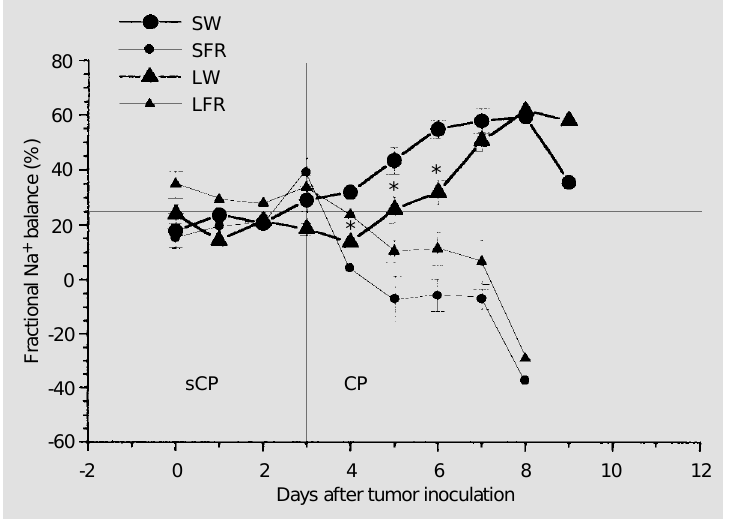
Figure 3 - Time course of sodium retention induced by the tumor in septal-lesioned tumor-bearing rats (LW; N = 15) compared with sham-operated tumor-bearing rats (SW; N = 7) and their respective non-tumor-bearing controls, sham-operated food- restricted (SFR; N = 7) and lesioned food-restricted (LFR; N = 10) rats. The fractional sodium balance was calculated as (input-output) x 100/input, where input is the food intake (g/day) x diet sodium content (mEq/g), and output is the urine volume (ml/day) x urine sodium concentration (mEq/ml). During the clinical period (CP), the tumor- induced Na + retention was temporarily reduced in LW rats compared with SW rats (least significant difference test, *P<0.05 for SW x LW). sCP, Subclinical period.